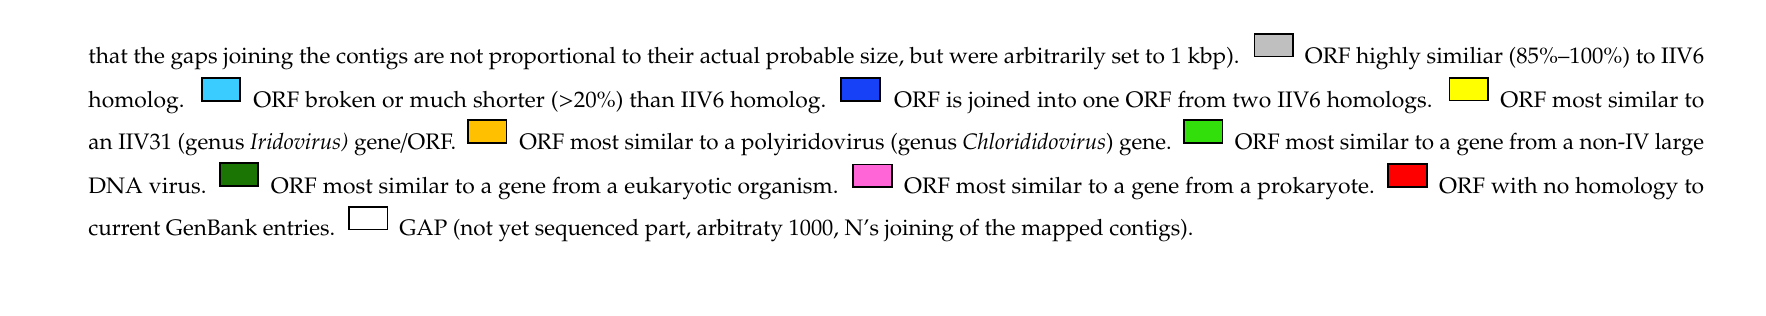
Figure 3. Putative genomic map of the chameleon IIV isolate (Ir. iso. 1) constructed based on nine contigs of an Illumina de novo assembly, and applying the ORF numbering of IIV6. Red dotted rectangles indicate the genome regions, which were earlier covered by a Sanger method based comparison of the isolates (please note that the gaps joining the contigs are not proportional to their actual probable size, but were arbitrarily set to 1 kbp).